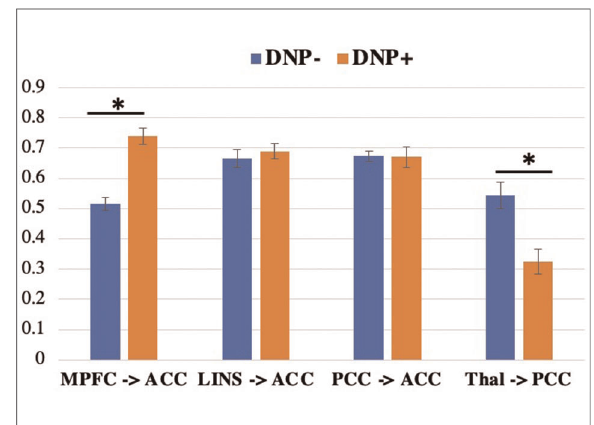
FIGURE 2 Connectivity subgroup differences in group-level paths. DNP+ had a greater MPFC to ACC path and a lower thalamus to PCC path, compared to subgroup DNP − . * p <0.05 (uncorrected). Note: MPFC, medial prefrontal cortex; ACC, anterior cingulate cortex; LINS, left insula; PCC, posterior cingulate cortex; Thal,